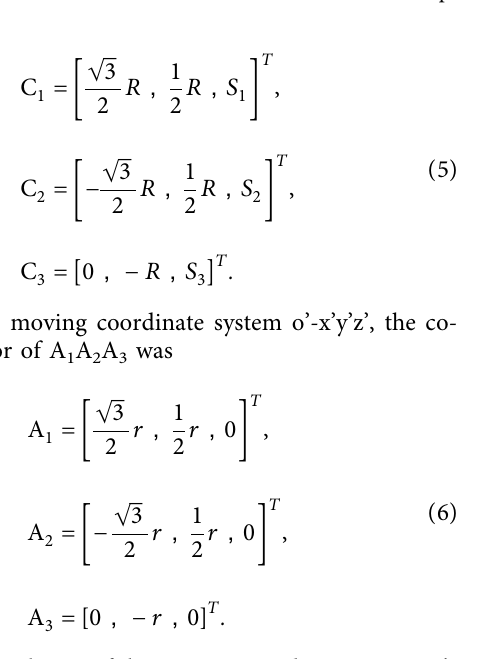
Figure 6: The schematic representation of a 3-PRS